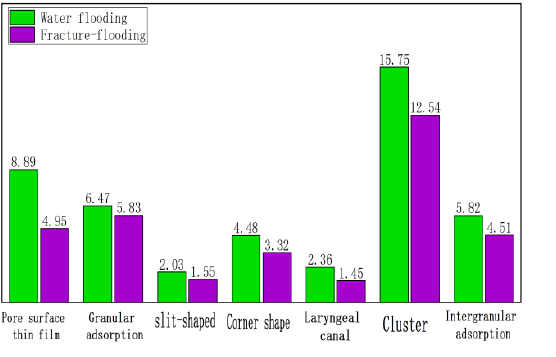
Figure 12 . Comparison of remaining oil content of different types of a confocal scanning laser. Figure 12. Comparison of remaining oil content of different types of a confocal scanning